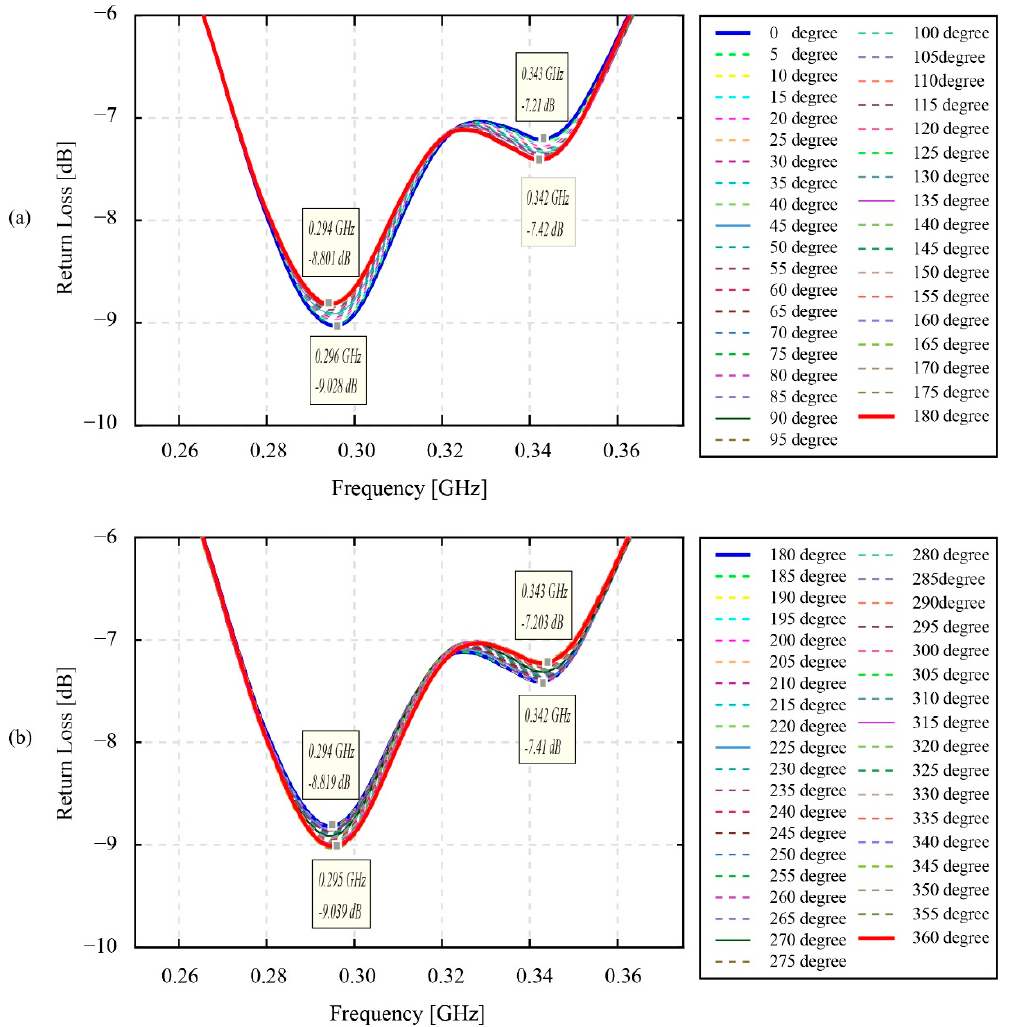
Figure 13. The effect of phase fluctuation on the resonant signals in the static conditions in the range of 0.2–0.4 GHz: ( a ) range of 0 degrees to 180 degrees; ( b ) range of 180 degrees to 360 degrees.